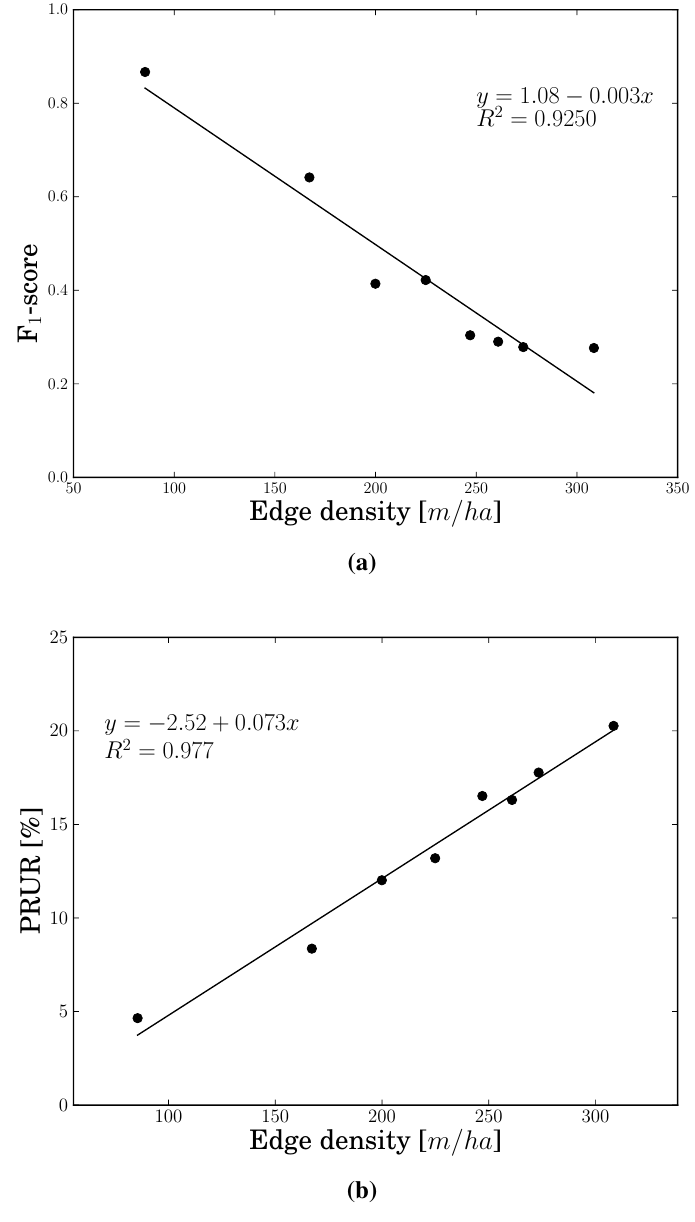
( a ) Habitat fragmentation is an indicator of the achieved accuracy. The higher the fragmentation, the lower the accuracy rate. ( b ) Simulated reduction of the unreachable region for a spatial resolution of 100 m corresponding to that of PROBA-V. In a fragmented habitat, a product at 100 m would reduce the low -resolution bias by